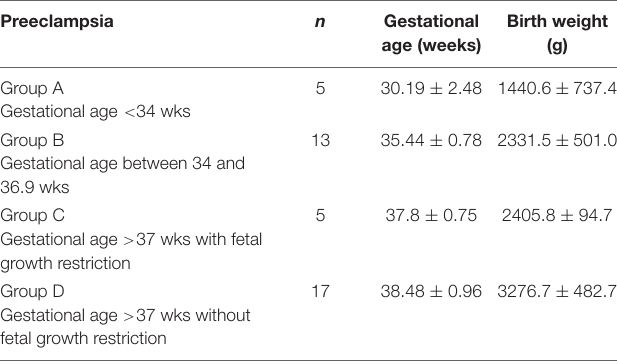
TABLE 2 | Characteristics of studied preeclamptic population accordingly the different presentations of preeclampsia. Preeclampsia n Gestational